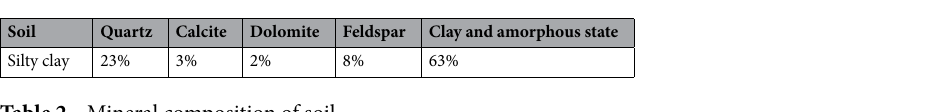
Table 2. Mineral composition of